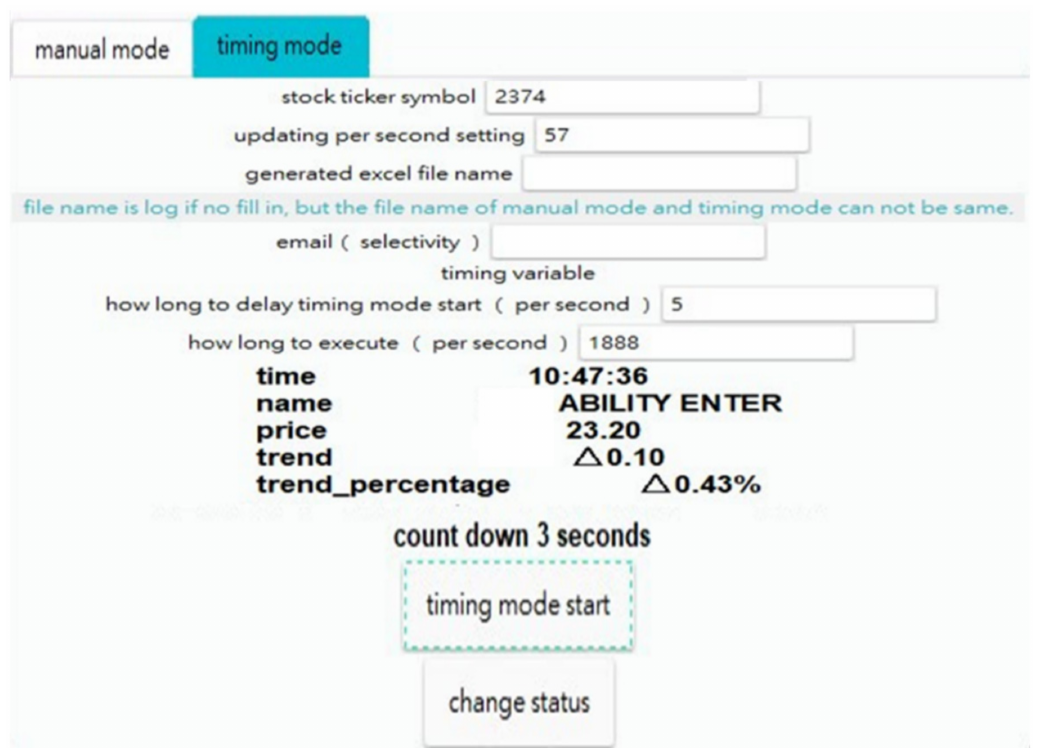
Figure 15. Timing mode count down 3 s will auto stop.